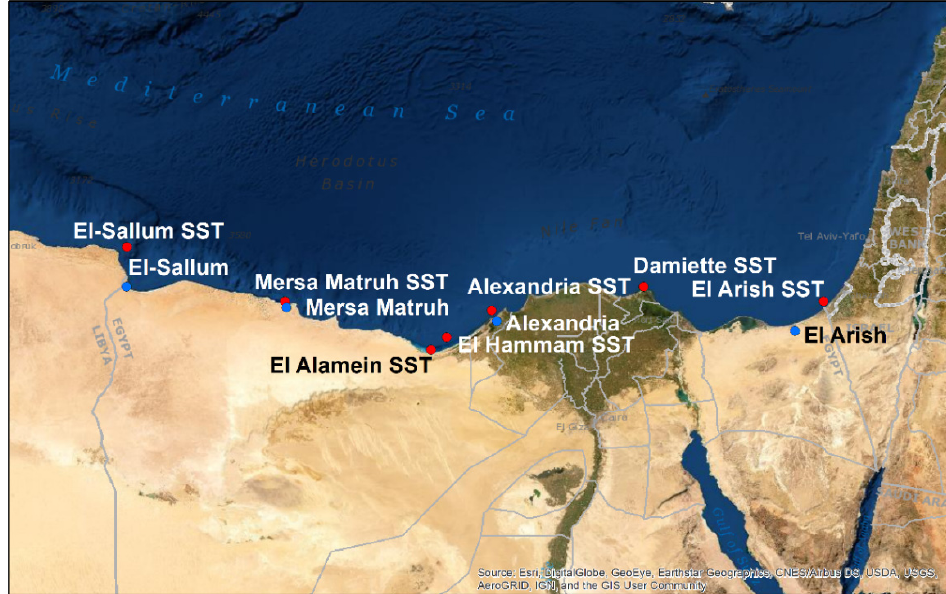
Figure 1. Stations collecting biological and meteorological data (red and blue dots) along the north coast of Egypt. The red dots indicate localities where detailed analyses were performed. SST: sea surface temperature.